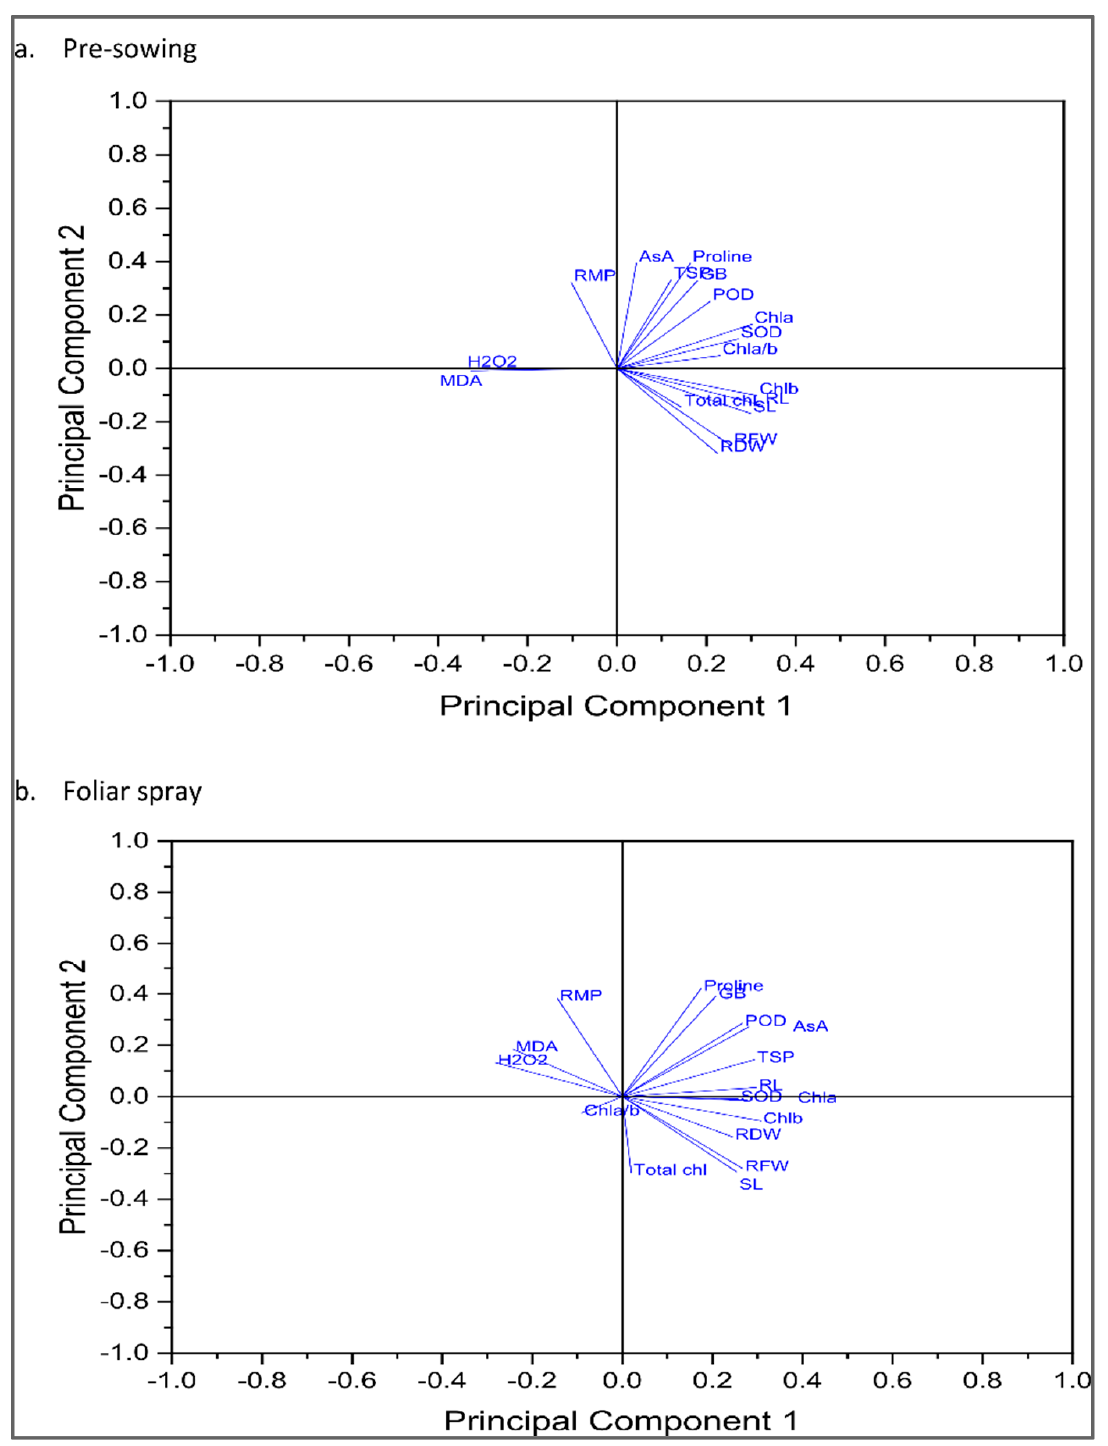
Figure 6. Principal component analysis of eggplants subjected to exogenous (( a ) pre-sowing (PS) and ( b ) foliar spray (FS)) application of TOC under water deficit (50% FC) and control (100% FC) conditions ( n = 4).